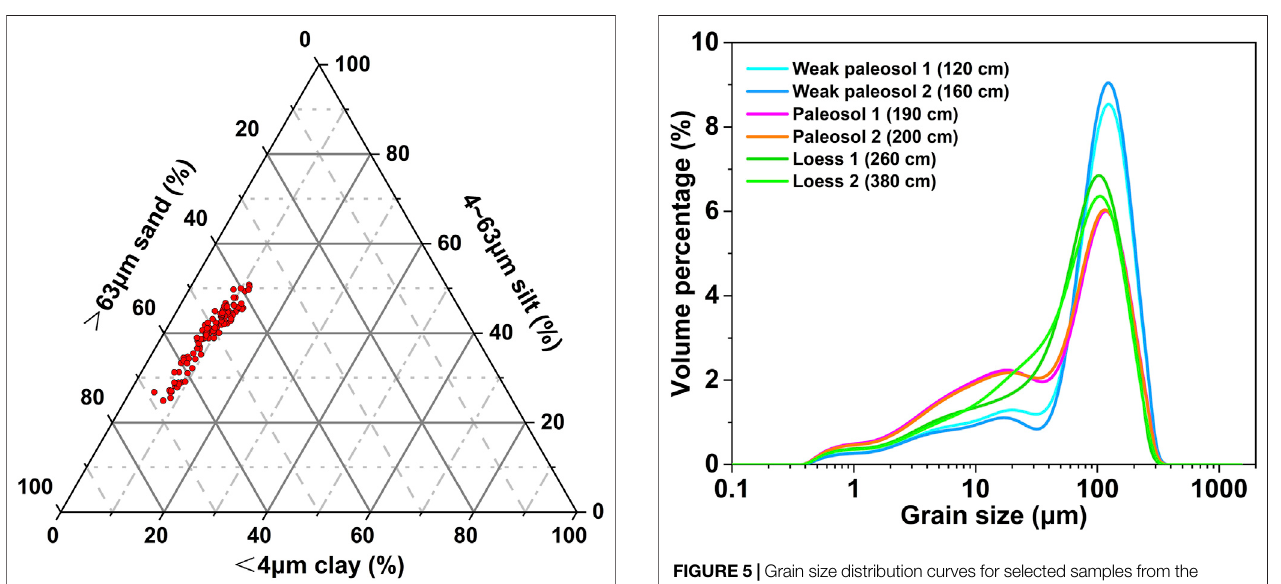
FIGURE 5 | Grain size distribution curves for selected samples from the NJ